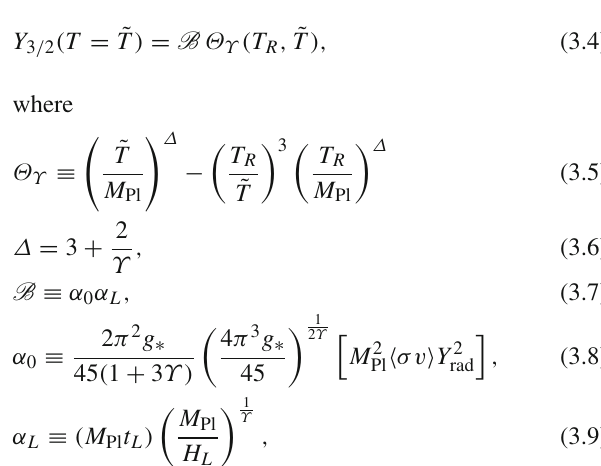
= 10 − 5 ( lower panel ) b